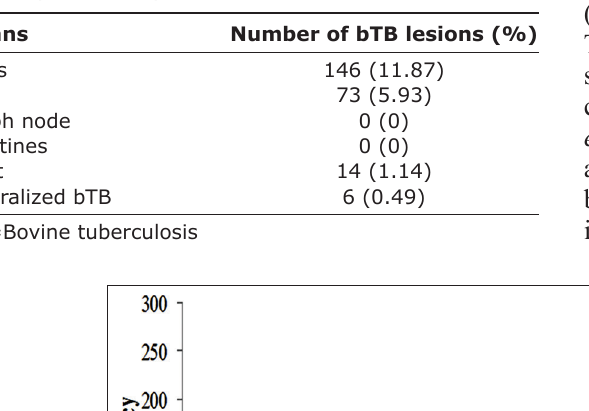
Table-3: Distribution of suspected gross bTB lesions in different organs of slaughtered cattle in Bauchi municipal abattoir (2004-2013).